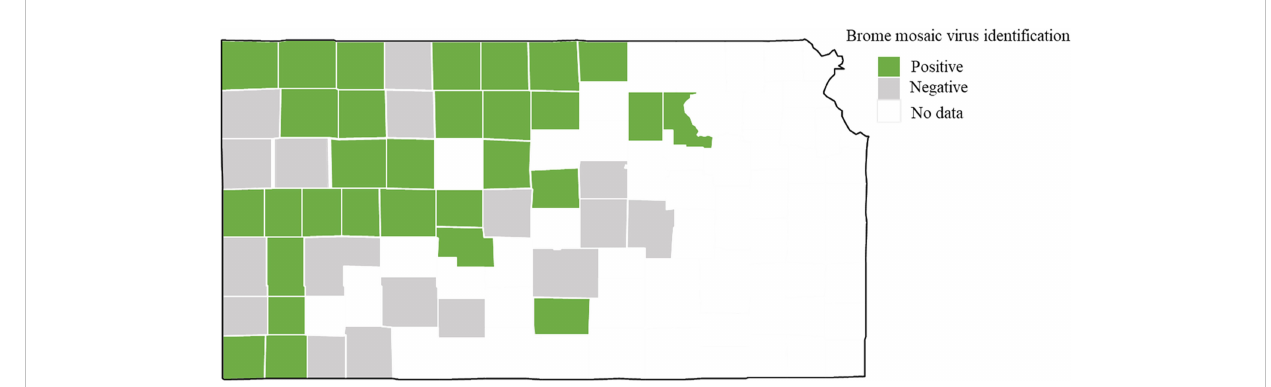
FIGURE 2 Map of Kansas with counties where brome mosaic virus was identi fi ed using Nanopore sequencing. Counties with no data indicates never sampled during this study.